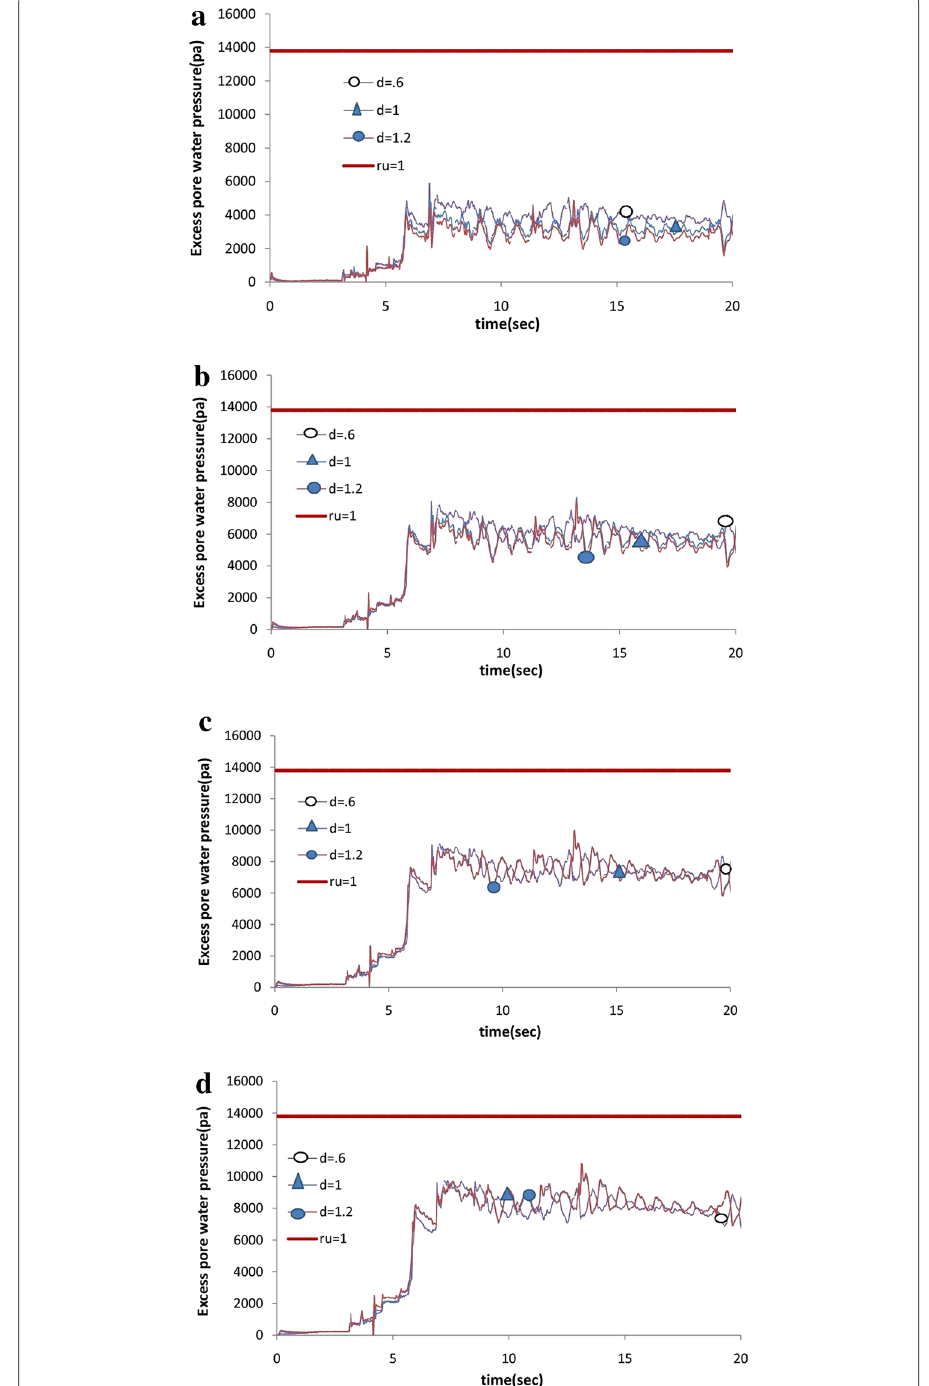
Fig. 11 Changes of excess pore water pressure for each three column’s diameter at depth 1.5 m from ground surface, a at distance of 1 m from column center, b at distance of 1.5 m from column center, c at distance of 2.5 m from column center, d at distance of 3.5 m from column